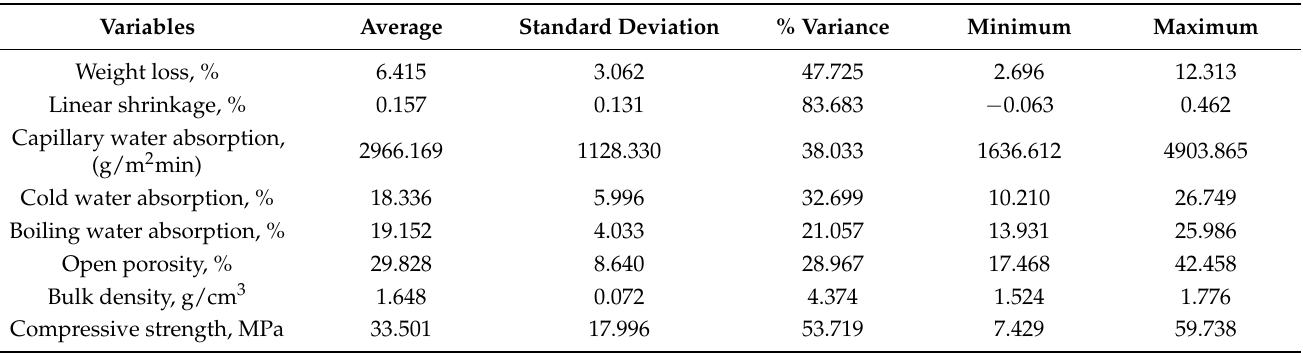
Table 2. Statistical summary of the data obtained from the tests to determine the physical and mechanical properties of geopolymers.